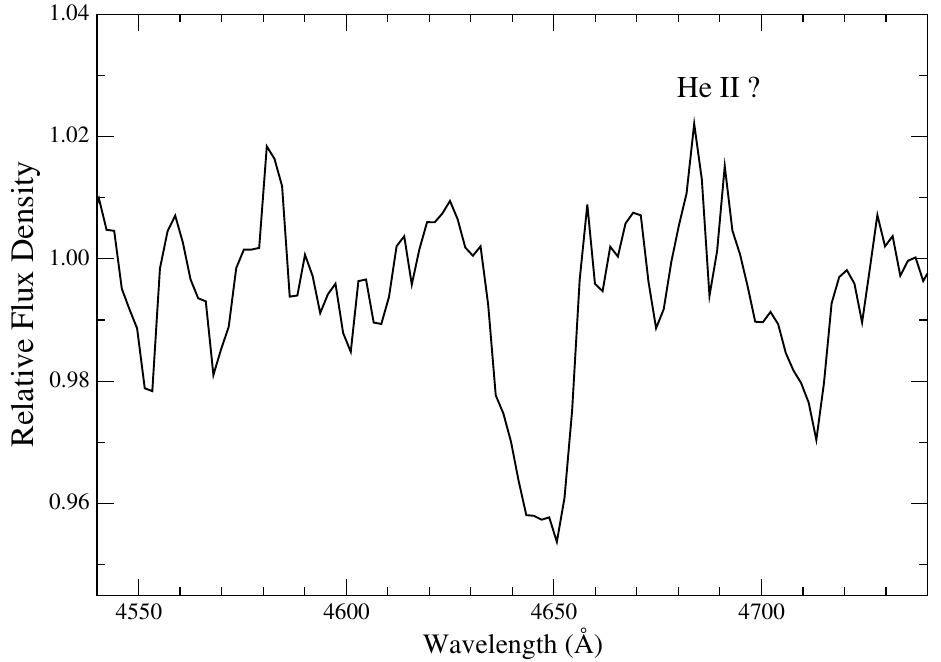
Figure 6. Low-resolution optical spectrum of LS 4686 as observed from the OUJA on 2020 September 2. The double-peaked He II emission line at 4686 Å could be present barely above the stellar